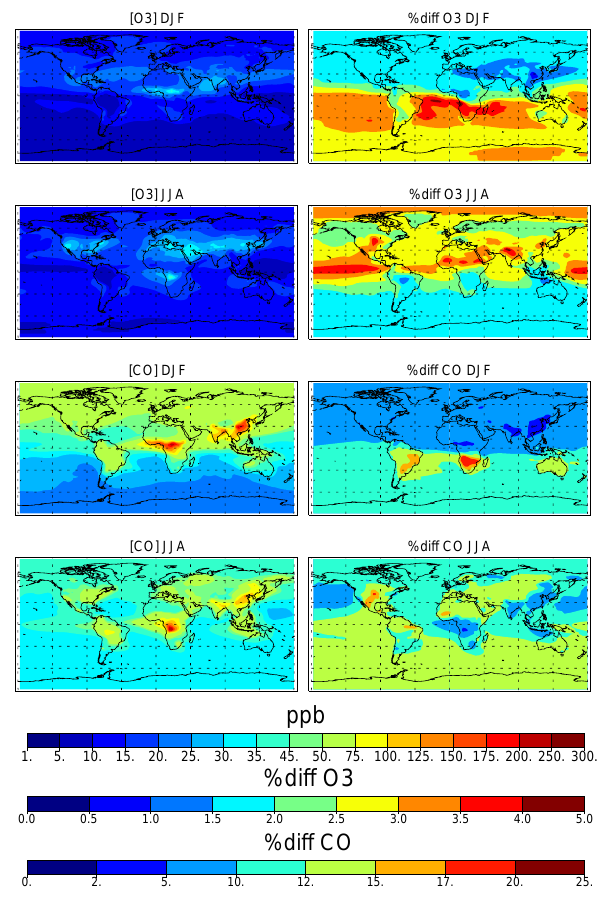
Fig. 3. Simulated seasonal mean distributions of O 3 and CO mixing ratios in the lower troposphere (surface to 750hPa) for seasons DJF and JJA (left panels) for the MEGAN simulations. The right panels show the corresponding relative contribution of C1-C3 BVOC emis- sions to the simulated global distributions (right panels). The rela- tive differences shown on the right are calculated using (MEGAN-